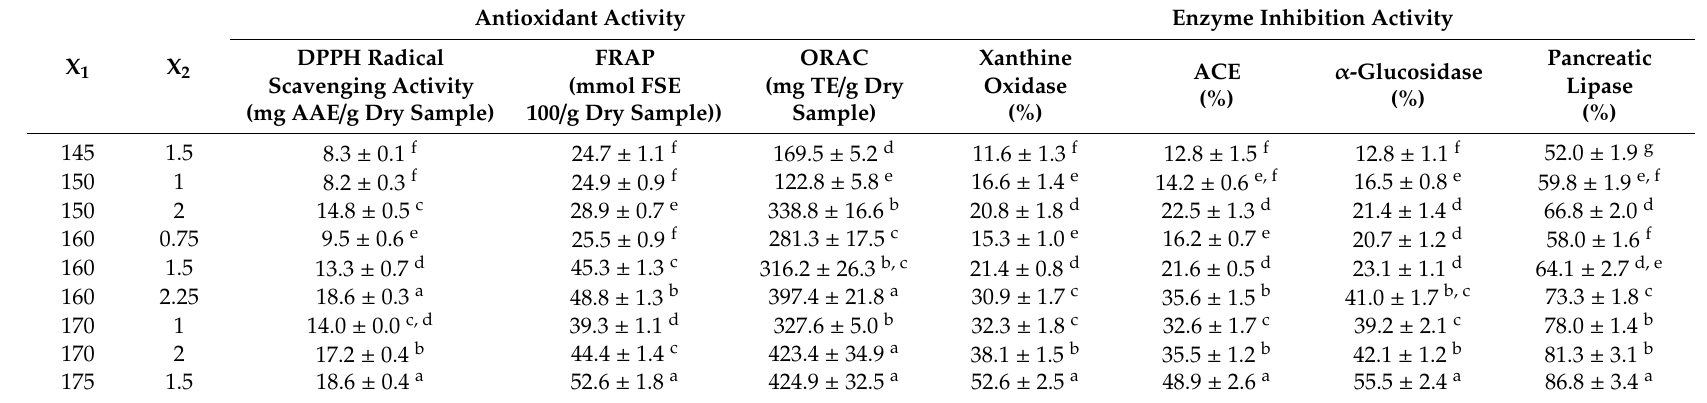
Table 3. Antioxidant activities and enzyme inhibitory activities in subcritical water extracts from C. unshiu